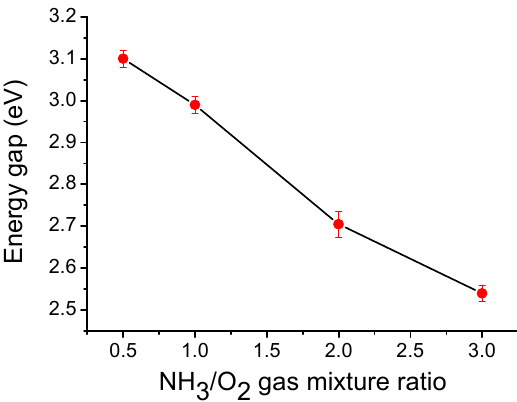
Figure 11. The decrease in the bandgap energy when the NH 3 /O 2 gas mixture ratio increased.